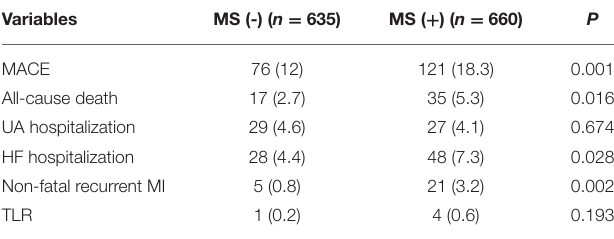
TABLE 2 | Comparison of clinical outcomes between two